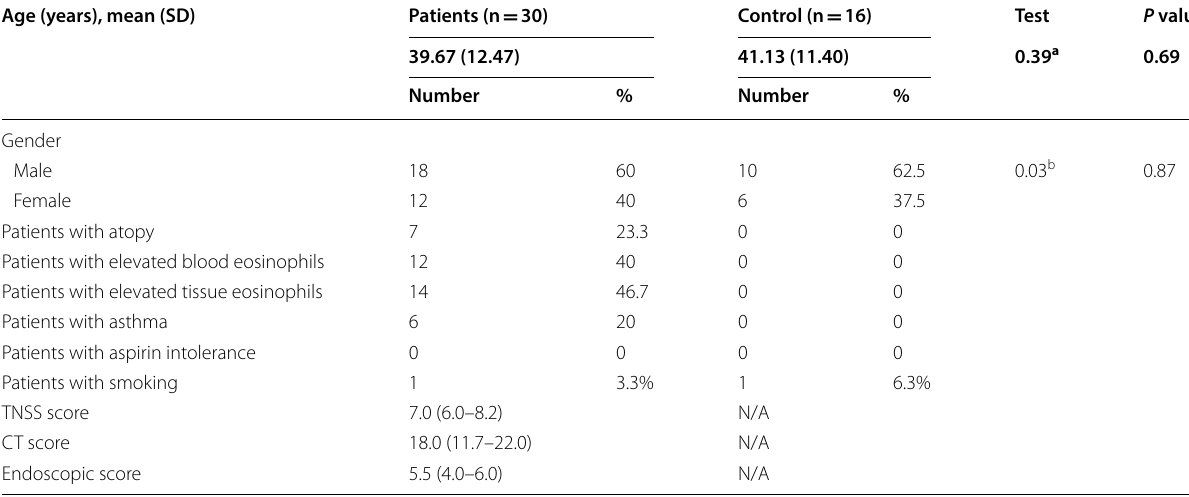
For TNSS, CT score and endoscopic score, results are expressed as medians and interquartile ranges TNSS total nasal symptom score, CT computed tomography, N/A not applicable a t-test b Chi square (χ 2 )